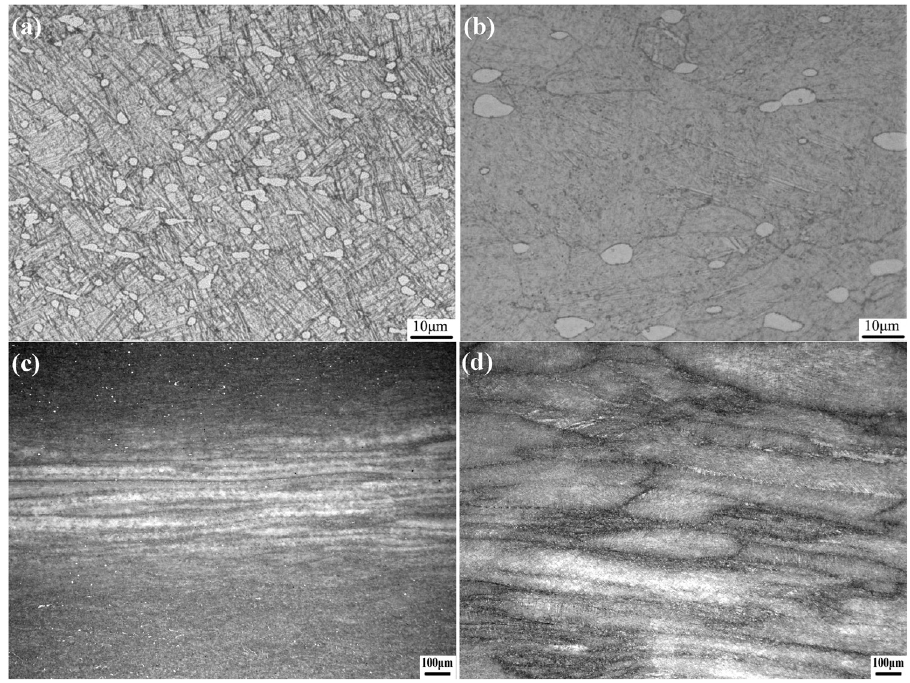
Figure 17: Microstructures after deformation at the same temperature of 940°C and di ff erent strain rates of ( a ) 0.001 s − 1 ; ( b ) 0.01 s − 1 ; ( c ) 1 s − 1 ; and ( d ) 10 s − 1 .